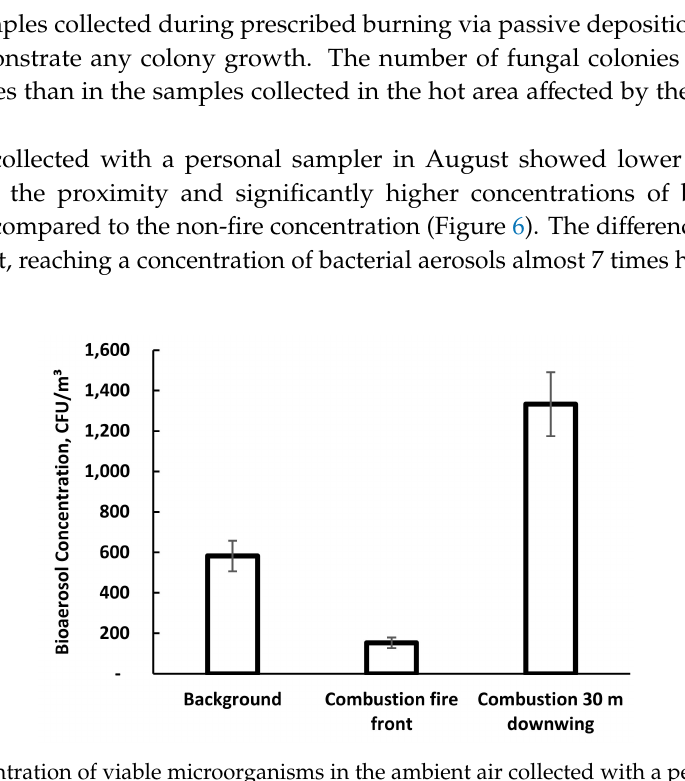
Figure 6. Concentration of viable microorganisms in the ambient air collected with a personal sampler during biomass combustion in the Gri ffi th series of experiments. Error bars show the standard deviation of five experimental